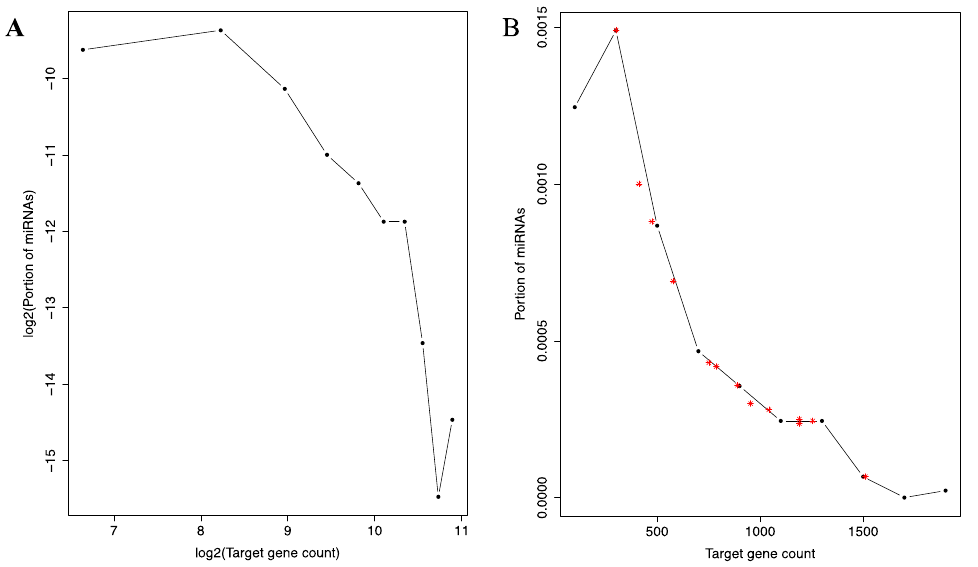
Figure 4. Histogram of miRNA binding site distribution across the miRNAs. A log-log plot ( A ) and an un-logged plot ( B ) of the histogram is shown. In A, the curve depicts a negative correlate that resembles previously described log-log histograms of many types of scale-free networks [36]. In B, the approximate location of five well-known tumor suppressive miRNAs are marked with red asterisks symbols to illustrate their higher than expected target gene counts.